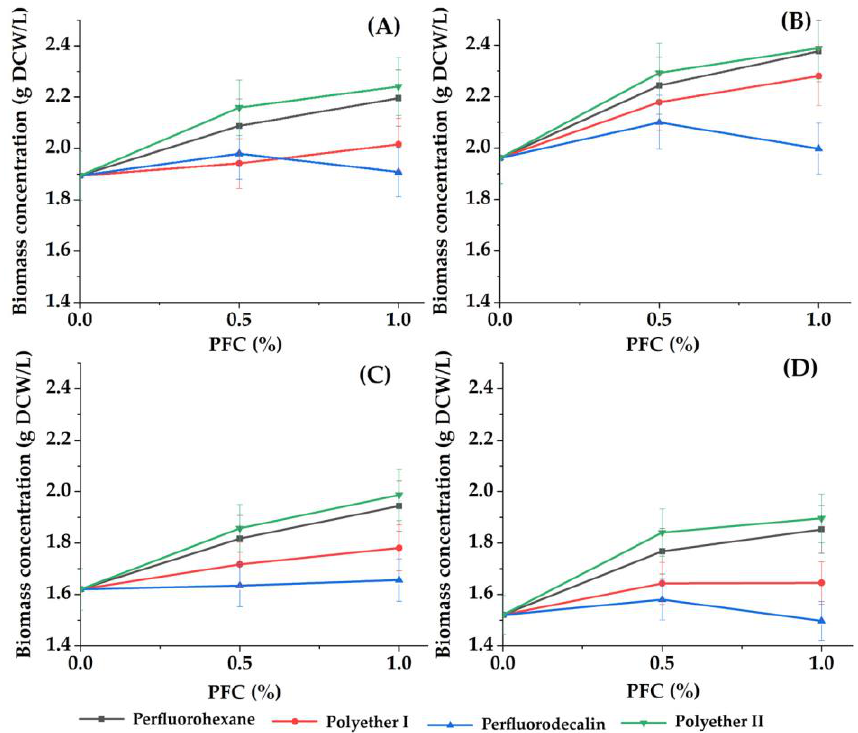
Figure 1. Dependence of the concentration of accumulated biomass of phototrophic microorganisms (( A ) C. vulgaris cells in Tamiya medium, ( B ) C. vulgaris cells in Tamiya medium with 1 g/L glycerol, ( C ) A. platensis cells in Zarrouk medium, ( D ) Nostoc sp. cells in the medium BG-11) on the concen- trations of different PFCs. Control: the concentration of accumulated cell biomass of phototrophic microorganisms when concentration of PFC was